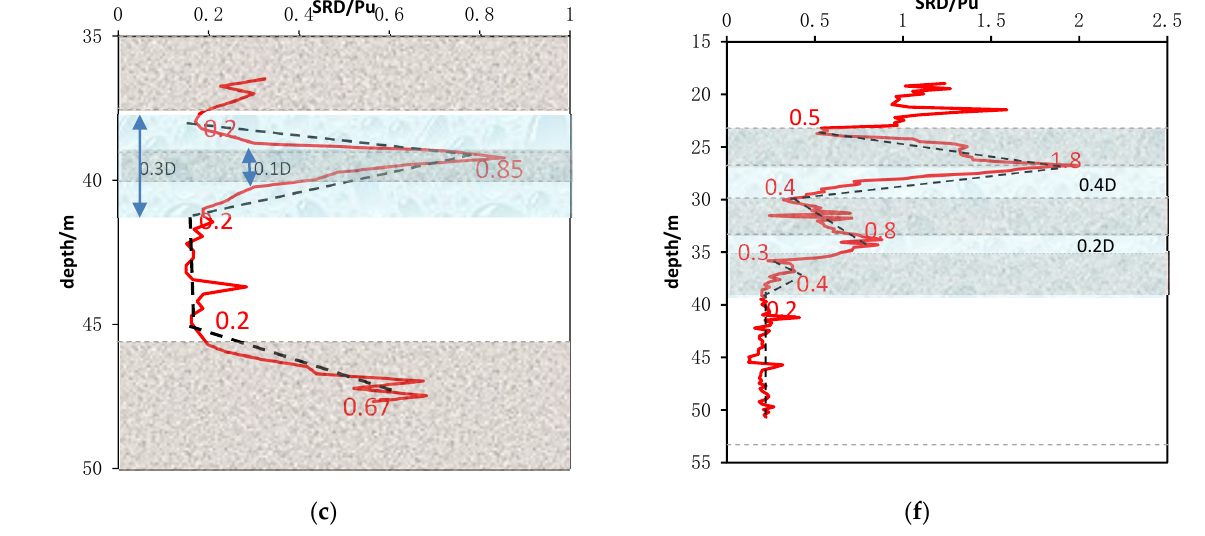
Figure 5. The change in SRD/Pu with depth. ( a ) Case 1 (a); ( b ) Case 1 (b); ( c ) Case 1 (c); ( d ) Case 2 (a); ( e ) Case 2 (b); ( f ) Case 2 (c).